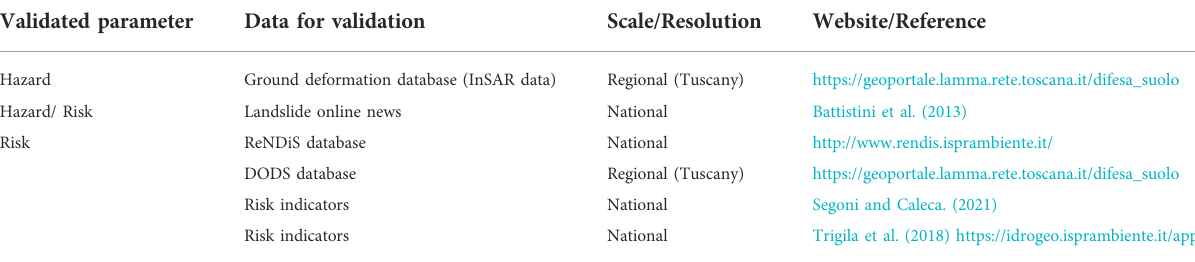
TABLE 1 The data to be validated and used for the validation process. Validated